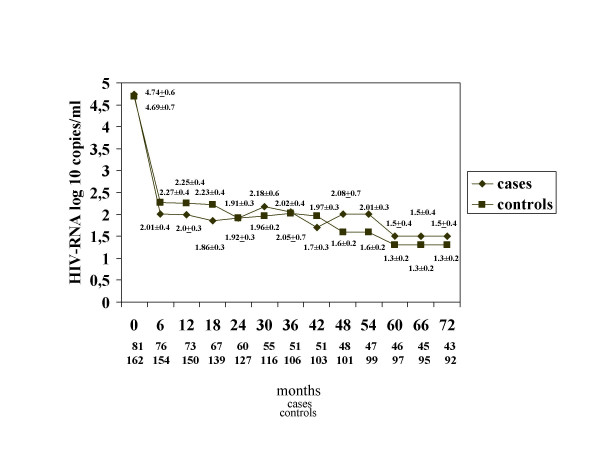
Comparison of HIV-RNA log 10 (mean ± SD) between cases and controls from baseline to the end of follow-up.